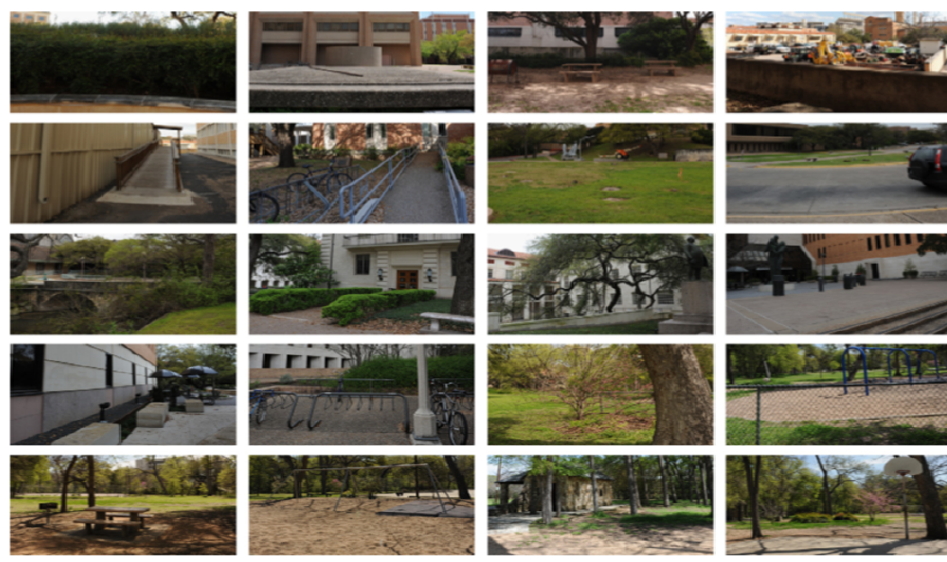
Figure 4. LIVE 3D IQA Image